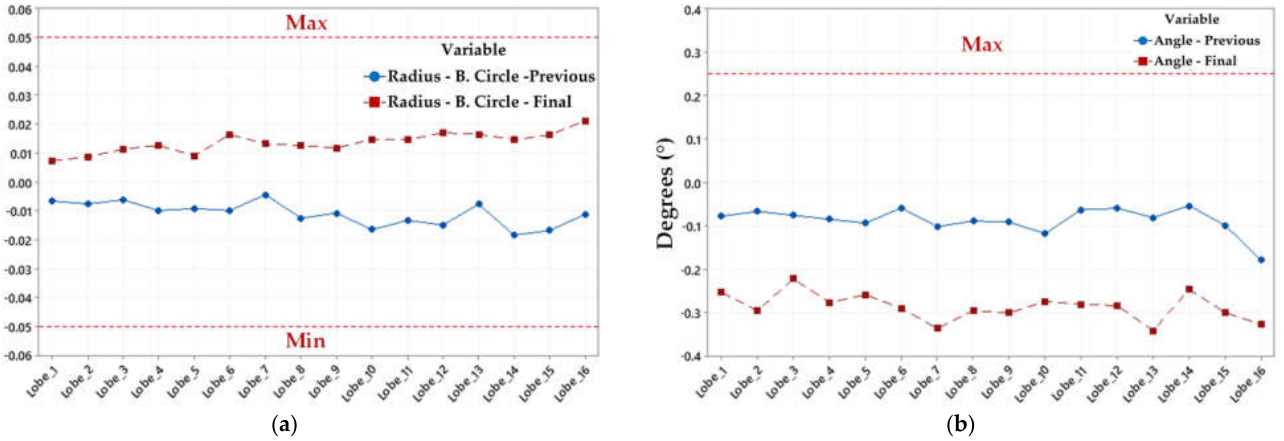
Figure 13. Dimensional measurements of the camshaft lobes before and after the spin rig test for ( a ) radius base circle, and ( b ) error angle.